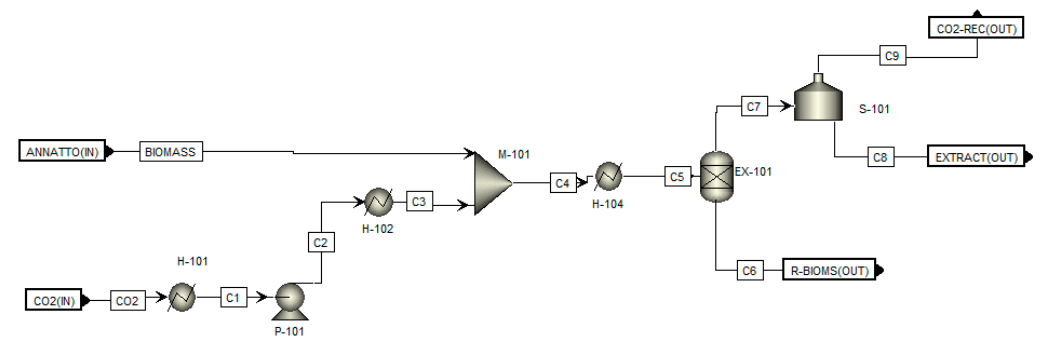
Figure A2. Flowchart of the supercritical fluid extraction (SFE) process for obtaining tocotrienols-rich extract from annatto seeds developed in Aspen Plus ® .